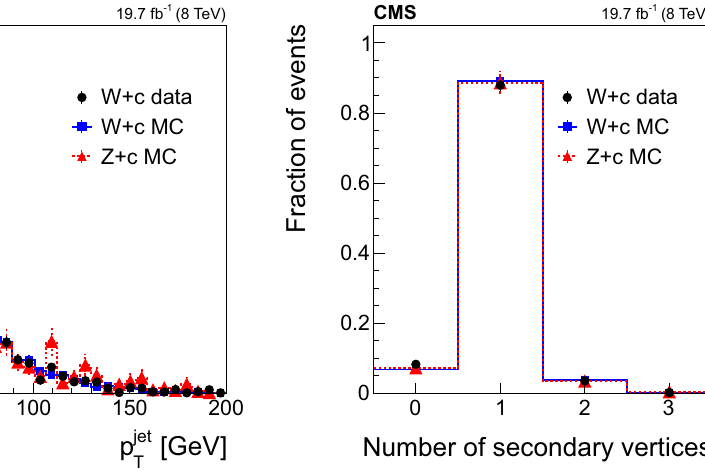
Fig. 4 Transverse momentum distribution of the c-tagged jet (left) and numberofreconstructedsecondaryvertices(right),normalizedtounity, in simulated W + c and Z + c samples and in W + c data events. The